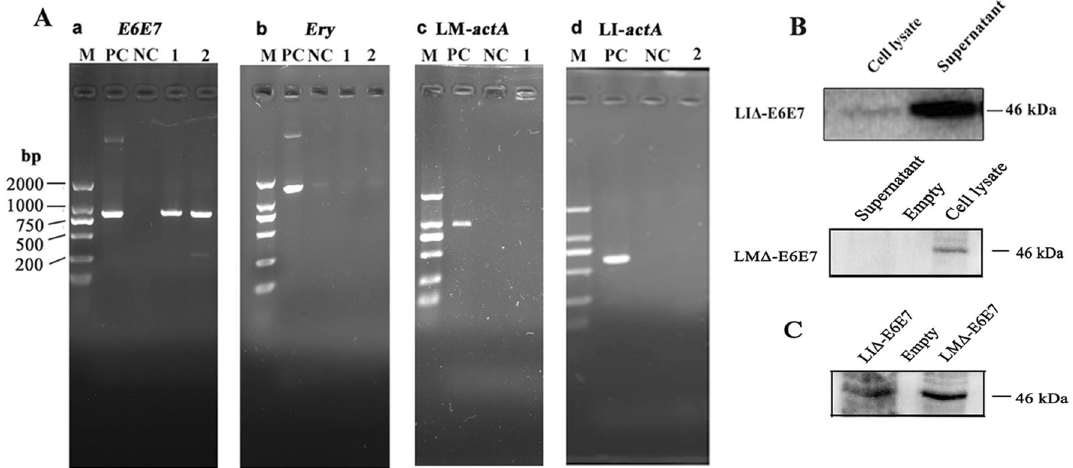
Figure 1. Protein and gene characterization of the recombinant LM and LI strains. ( A ) Genome PCR of the recombinant strains. (a) Amplification of E6E7 gene from LMΔ-E6E7 (1), LIΔ-E6E7 (2), negative control (NC) and positive control (PC). (b) Amplification of erythromycin resistance gene from LMΔ-E6E7 (1), LIΔ-E6E7 (2), negative control (NC) and positive control (PC). (c) Amplification of LM- actA gene from LMΔ-E6E7 (1), negative control (NC) and positive control (PC). (d) Amplification of LI- actA gene from LIΔ-E6E7 (2), negative control (NC) and positive control (PC). ( B ) Western blot of culture supernatant and cell lysate from the recombinant strains using the anti-HA monoclonal antibody as primary antibody. ( C ) Western blot of the supernatant of RAW264.7 cell lysate. The RAW264.7 cells were infected with both recombinant strains for 6 h individually, then supernatant of cell lysate was collected for Western blotting. Full-length blots/gels are presented in “Supplementary Fig. S1”. For 1B (LMΔ-E6E7) and 1C, after transferring, according to the protein molecular weight marker, the membranes containing 40–55 kDa protein bands was cut out for incubating with antibodies.